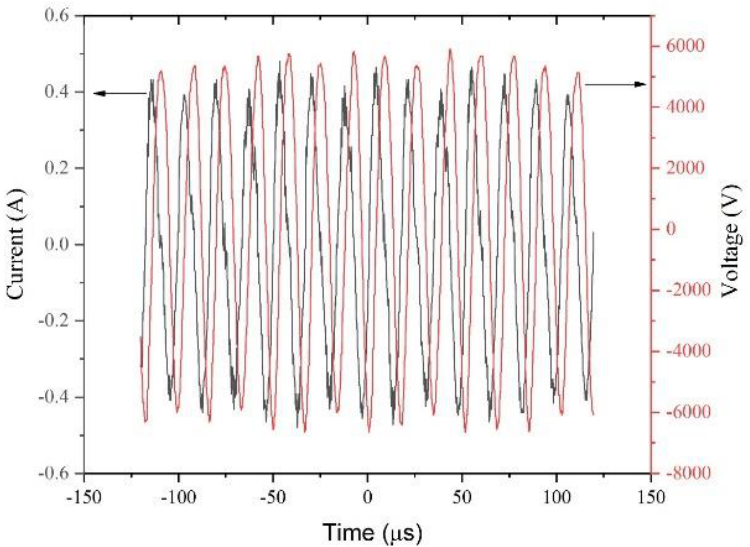
Figure 4. Current-voltage waveforms of the multihole plasma jet during the discharge power and frequency of 412 W and 76 kHz, respectively.